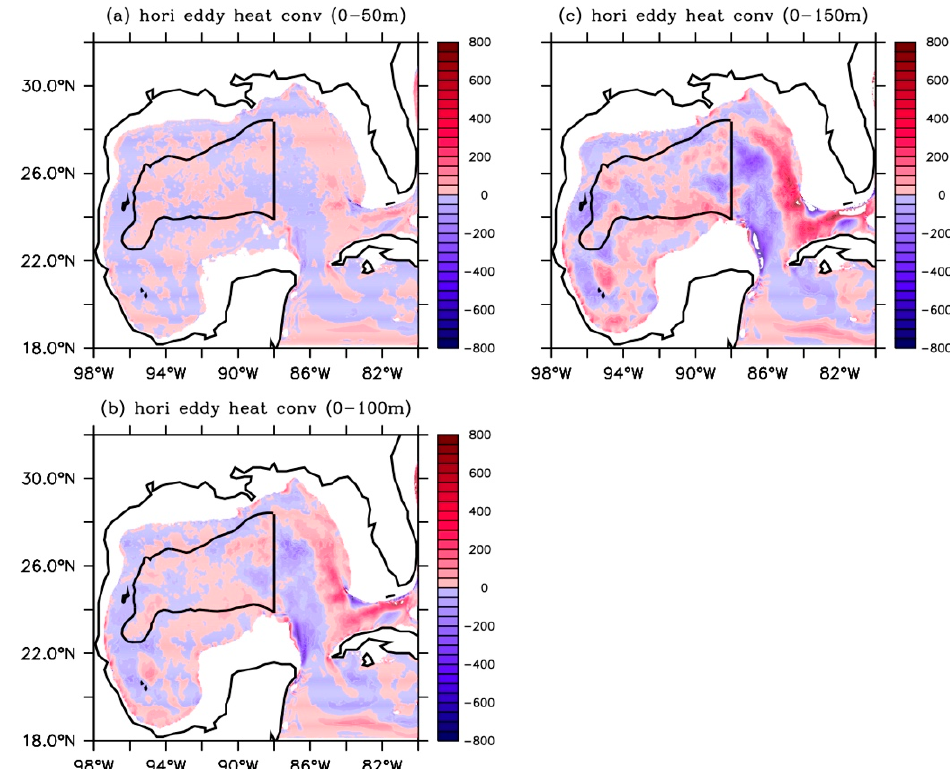
Figure 8. Maps of the time-mean horizontal eddy heat flux convergence (W m − 2 ) in the upper ( a ) 50 m, ( b ) 100 m, and ( c ) 150 m. Westward-migrating active eddies in the western GOM are primarily constrained in the surrounding region by the bold black curve, based on mean EKE spatial distribution derived from surface geostrophic velocity in AVISO. Positive values denote warming the ocean.